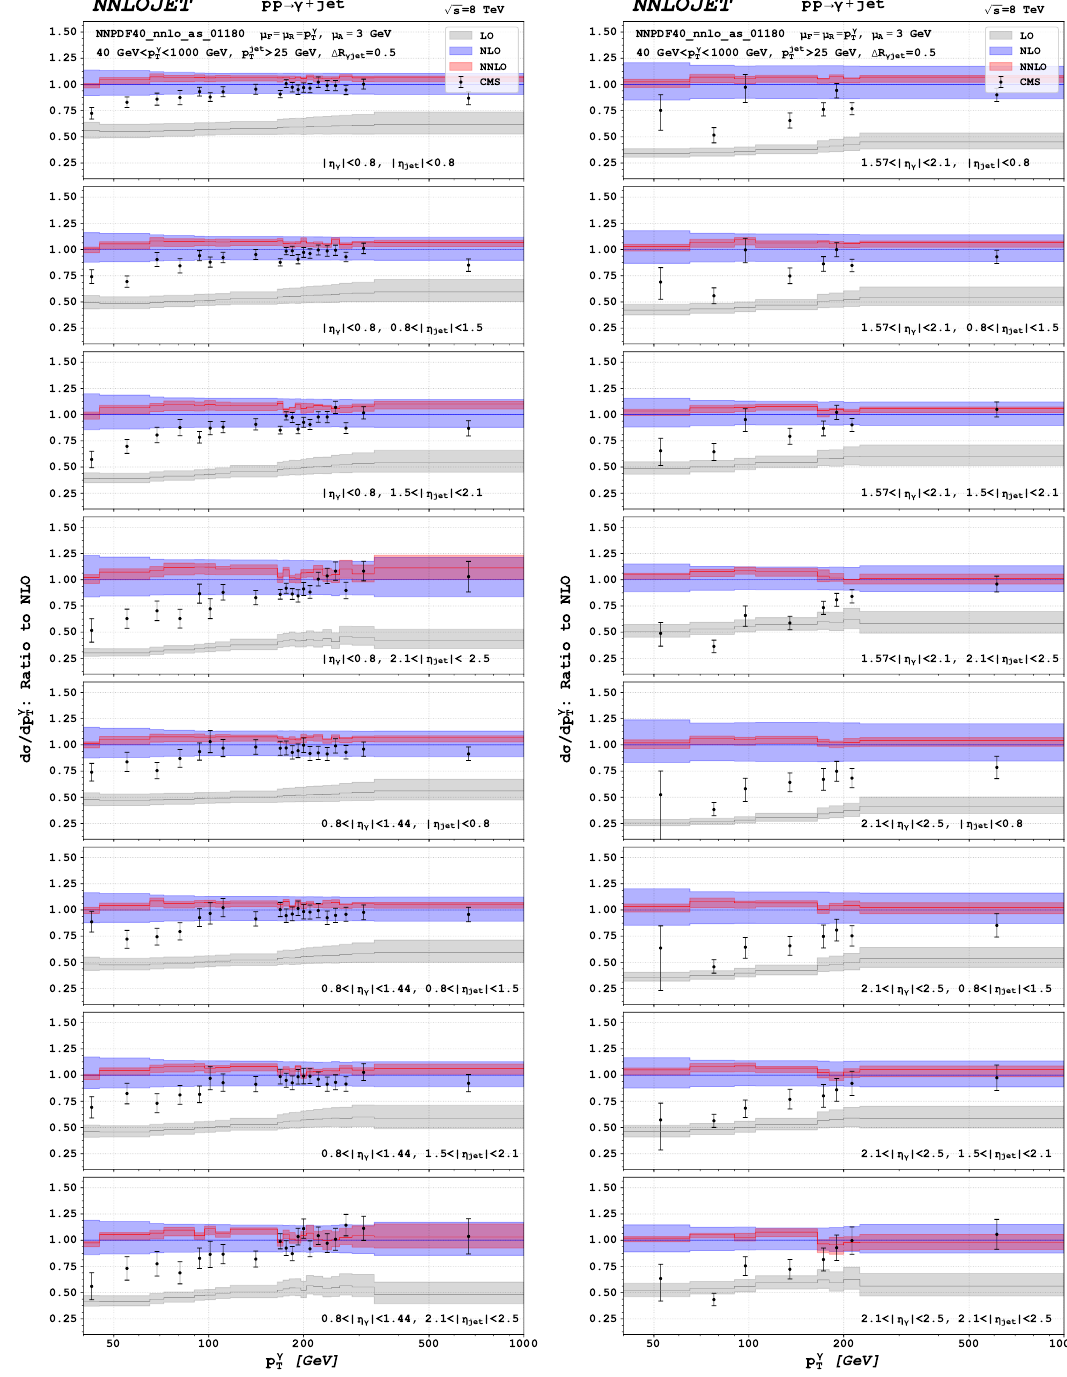
Figure 3. Photon transverse momentum distributions for different bins in the pseudorapidity of the photon and the jet. The predictions are compared to CMS 8 TeV data